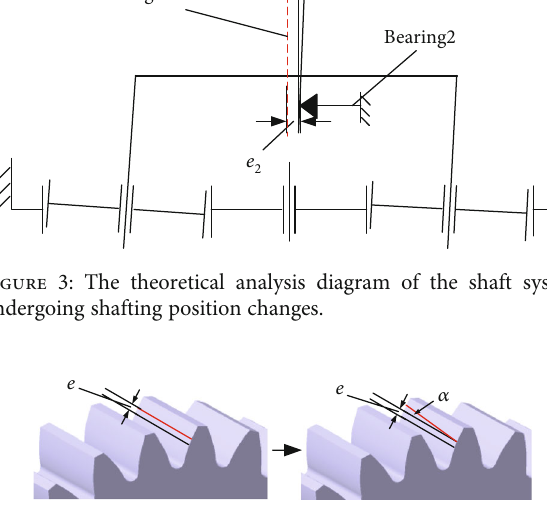
Figure 4: The changed meshing line of the